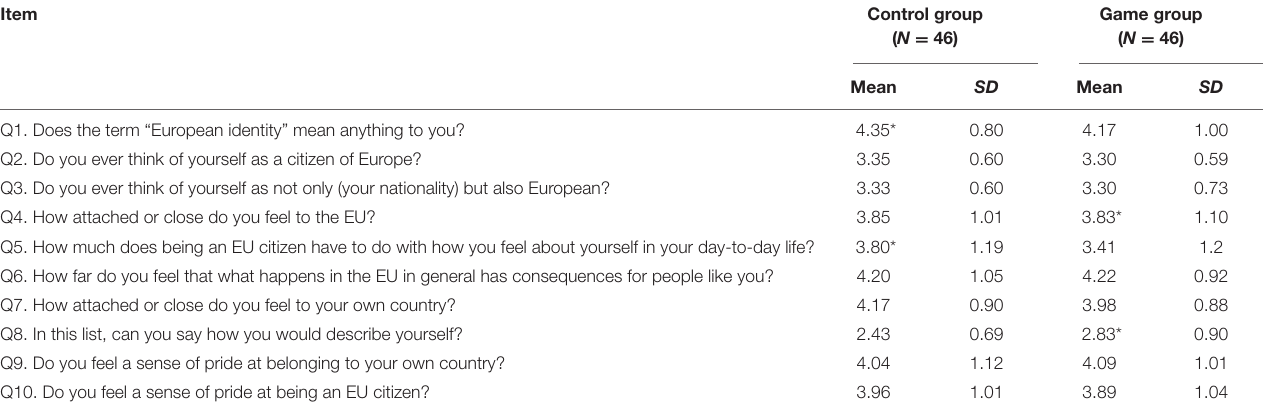
TABLE 3 | Students’ perceptions of European identity after the intervention.